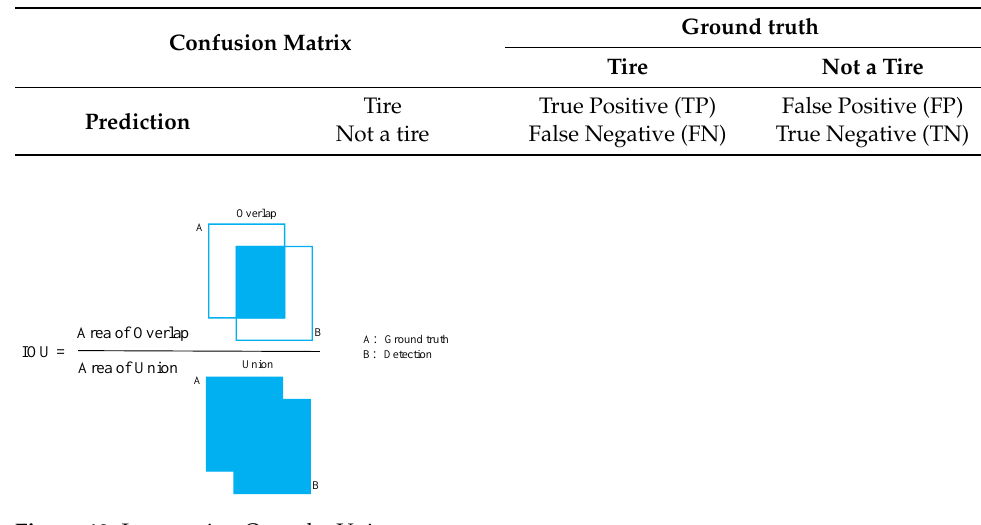
Table 2. Confusion matrix.